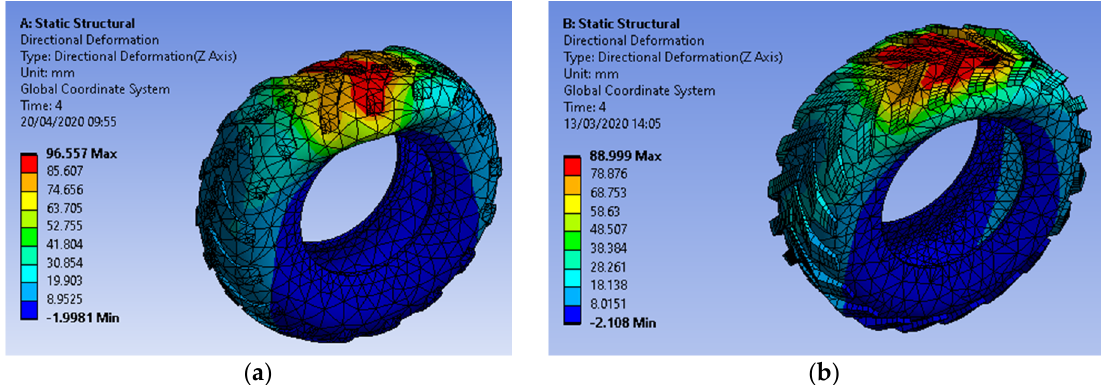
Figure 8. 3D FEM vertical deformations in direction of compression load i.e., for 420 / 85 R24 ( a ) and 460 / 85 R34 ( b ) at the inflation pressure of 1.0 bar.